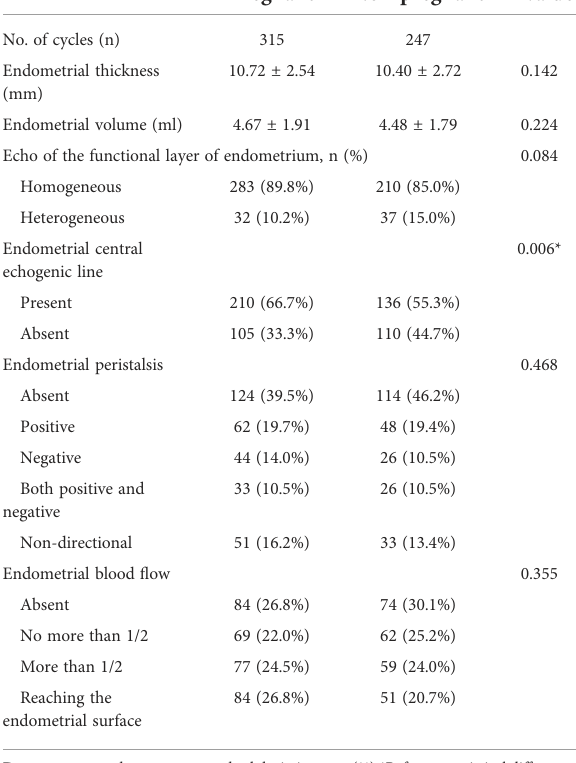
TABLE 2 Comparison of ultrasound parameters of endometrial receptivity between pregnant group and non-pregnant